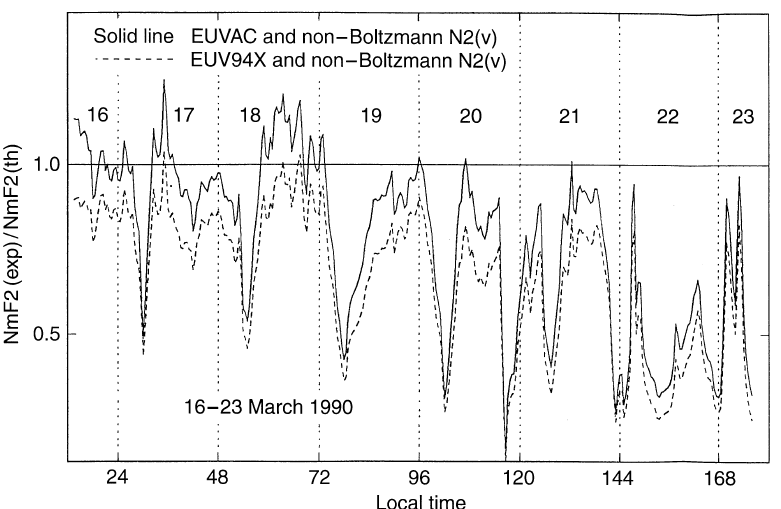
Fig. 5. Ratios of the measured F2 peak densities NmF2(exp) to the modeled F2 peak densities NmF2(th) during the 16–23 March 1990 period for the EUVAC solar flux model ( solid line ) and the EUV94X solar flux model ( dashed line ). The modeled NmF2 were obtained using the non- Boltzmann populations of the first five vibrational levels by solving the N 2 ( v = 1–5) time-dependent continuity equations, the O (cid:135) (cid:255) O collision fre- quencies given by Salah (1993), and the MSIS-86 model with adjusted recombination rate of the O (cid:135) (cid:133) 4 S